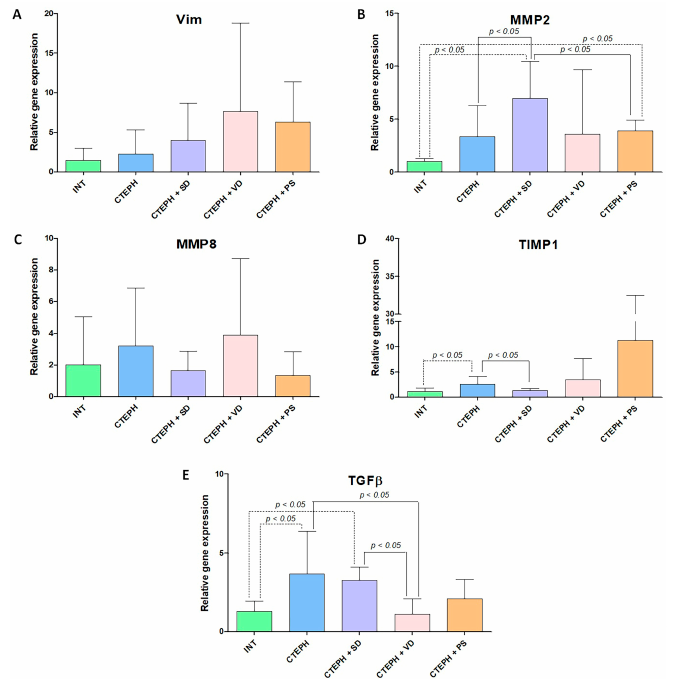
Figure 7. Analysis of expression of profibrotic factors in lung tissue in different experimental groups. (A) —relative gene expression of Vim, (B) —relative gene expression of MMP2, (C) —relative gene expression of MMP8, (D) —relative gene expression of TIMP1, (E) —relative gene expression of TGF β . INT—intact animals (n = 8), CTEPH—chronic thromboembolic pulmonary hypertension (n = 11), CTEPH + SD—CTEPH + sympathetic denervation (n = 8), CTEPH + VD—CTEPH + vagus denervation (n = 6), CTEPH + PS—CTEPH + pyridostigmine (n = 5). Vim—vimentin, MMP2—matrix metalloproteinase-2, MMP8 - matrix metalloproteinase-8, TIMP1—tissue inhibitor of metalloprote- ase-1, TGF β —transforming growth factor beta. MMP2 gene expression was significantly lower in INT group than in CTEPH + SD and CTEPH + PS groups ( p < 0.05, Figure 7B). Further, MMP2 expression was higher in CTEPH + SD group versus CTEPH as well as CTEPH + PS groups (Figure 7B). TIMP1 gene expression was significantly higher in CTEPH group than in CTEPH + SD and INT groups (Figure 7D). TGF β expression was higher in CTEPH and CTEPH + SD groups versus INT group (Figure 7E). However, TGF β expression was reduced in CTEPH + VD group in comparison with both CTEPH and CTEPH + SD groups (Figure 7E).